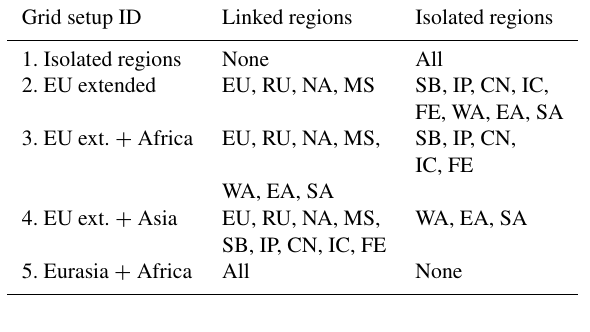
Table 3. Transmission grid setups. While all regions are always present in the simulation, some of them are not connected to a grid. Node to node links correspond to topology suggested in Fig. 1 Grid setup ID Linked regions Isolated regions